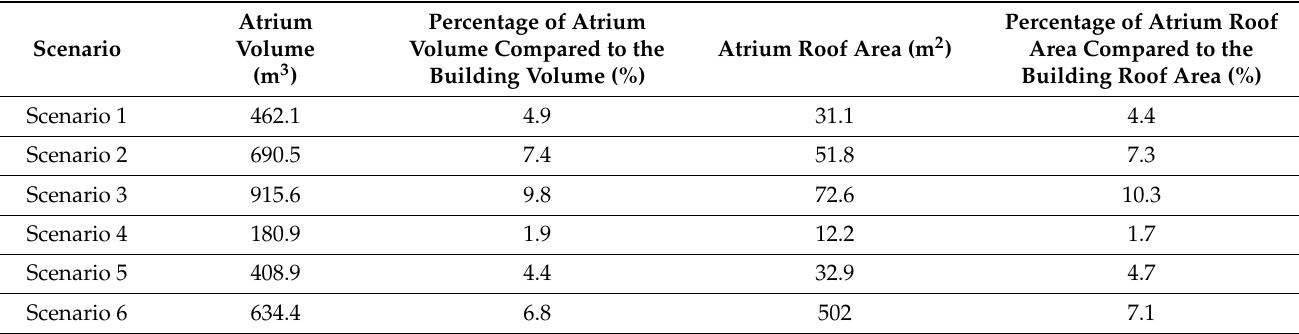
Table 1. The detailed characteristics of considered atria area and volume in each